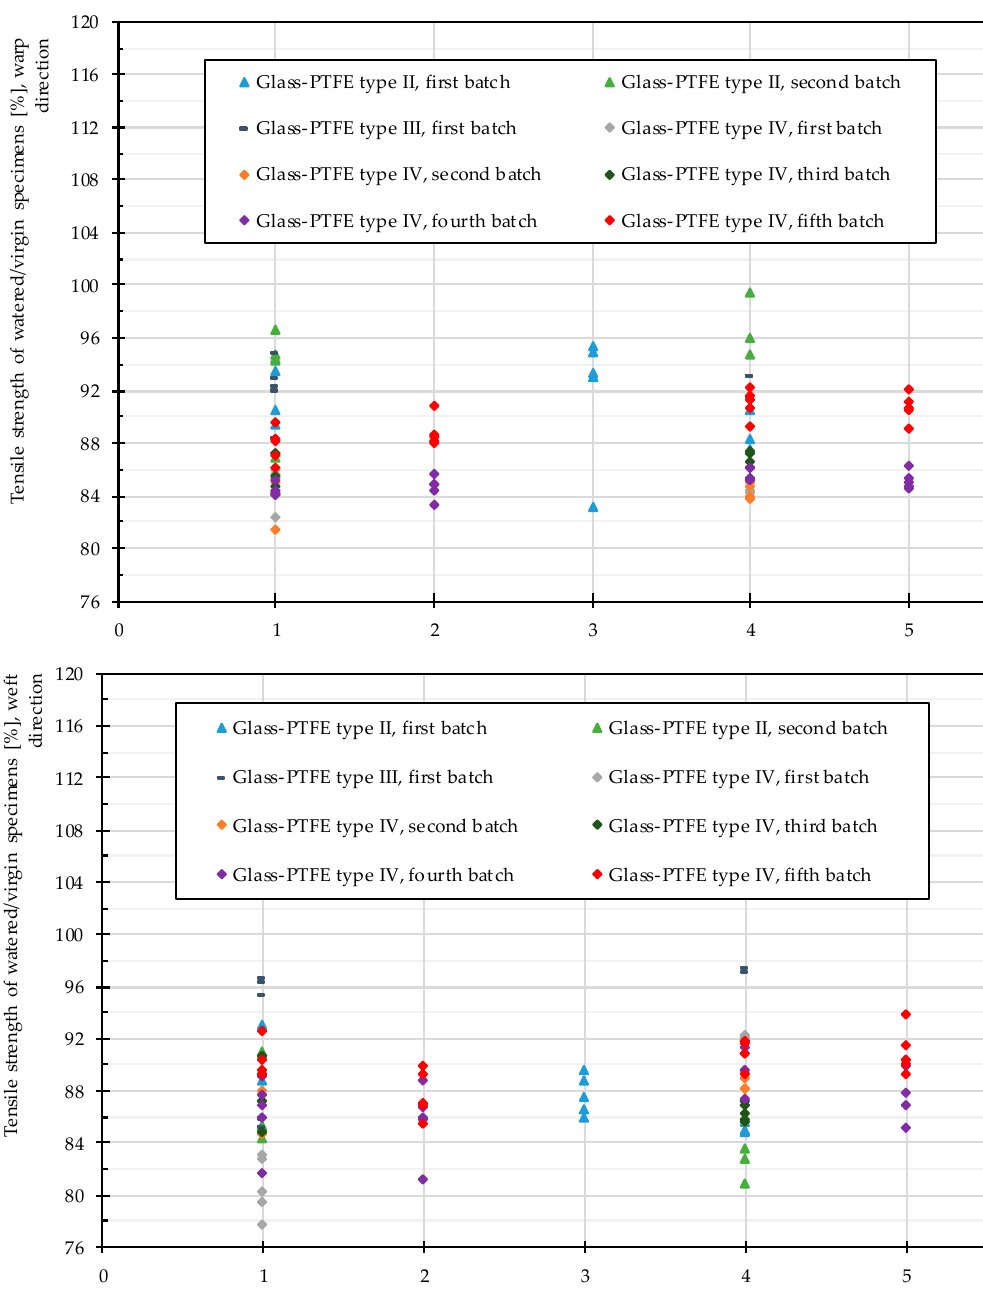
Figure 17. Changes in the tensile strength of glass-PTFE samples according to Table 3 for 1: in-plane and out-of-plane watering (two surfaces), 2: in-plane and out-of-plane watering (two surfaces) without surfactant, 3: out-of-plane watering (one surface), 4: out-of-plane watering (two surfaces), and 5: out-of-plane watering (two surfaces) without surfactant. All are watered for 144 h. Table 6. Residual tensile strength of glass-PTFE for different water seepage mechanisms.